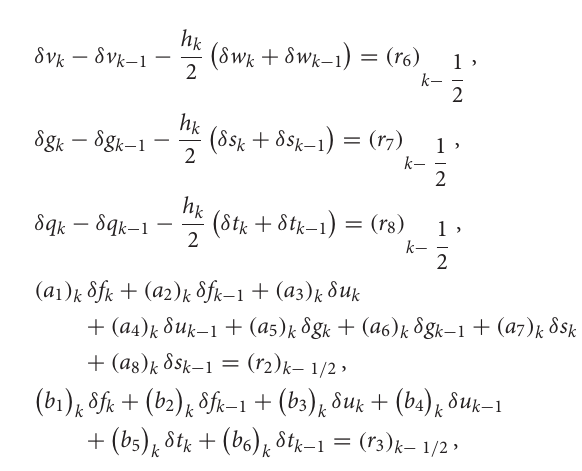
FIGURE 12 | Behavior of g ( ξ ) for different β